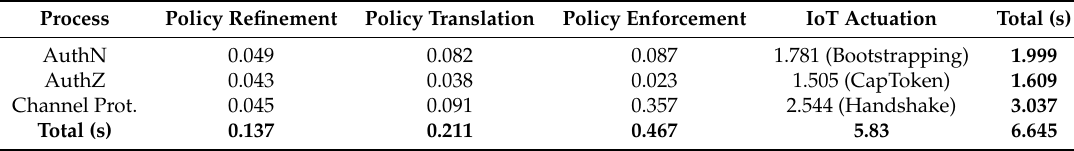
Table 2. Measurements by